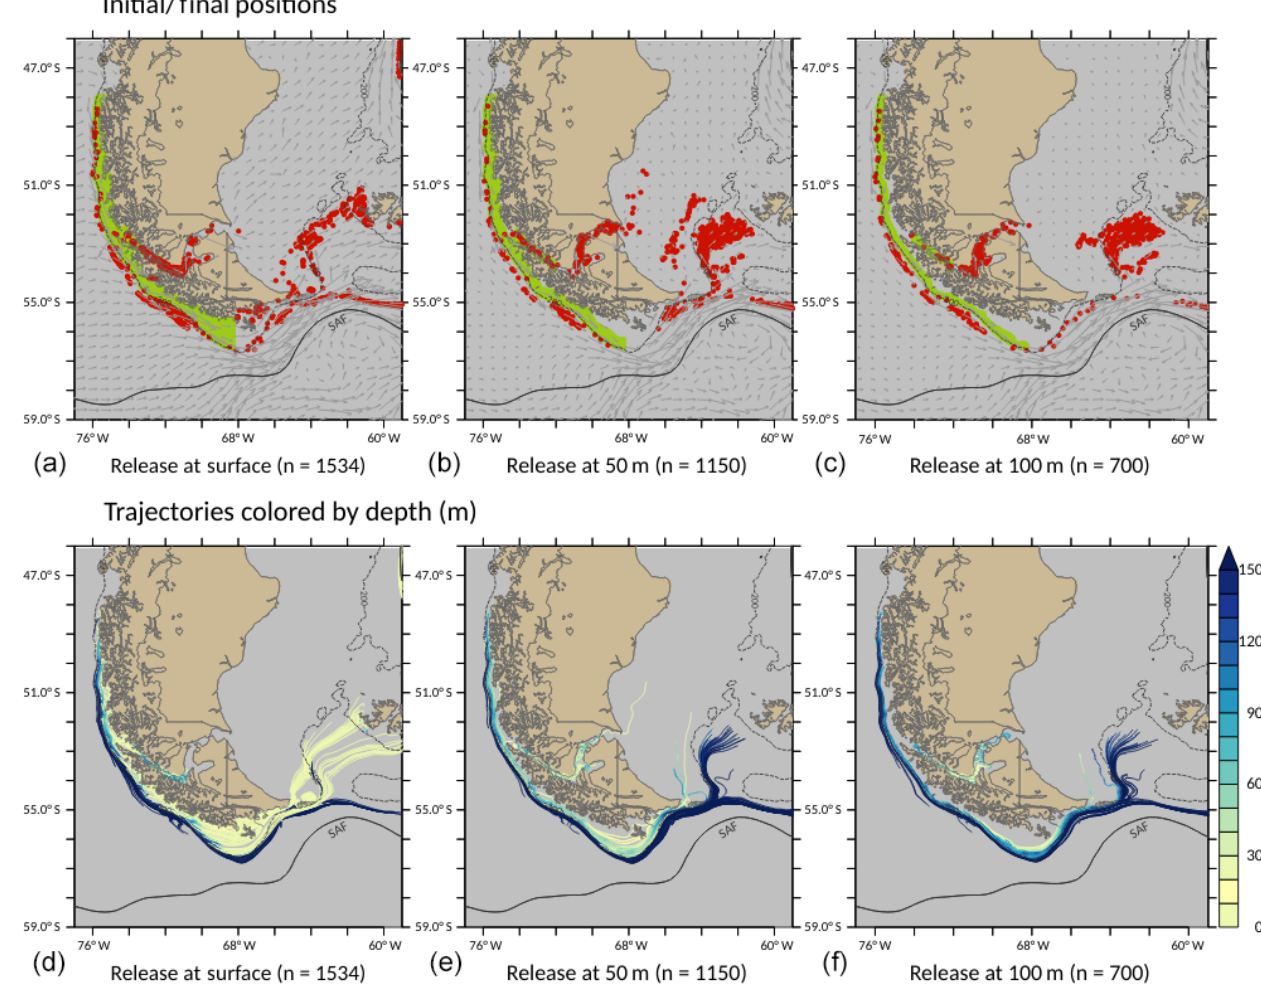
Figure 4. Forward Lagrangian advection of particles during 90d released on the SCHS. Initial positions (green) and final positions (red) of particles released at 0m (a) , 50m (b) , and 100m (c) . Vectors show the velocity at each depth. Particle trajectories colored by depth (m) for initial release at 0m (d) , 50m (e) , and 100m (f) (1 out of 20 trajectories shown). The number of particles ( n ) for each experiment is shown, and the SAF is indicated in